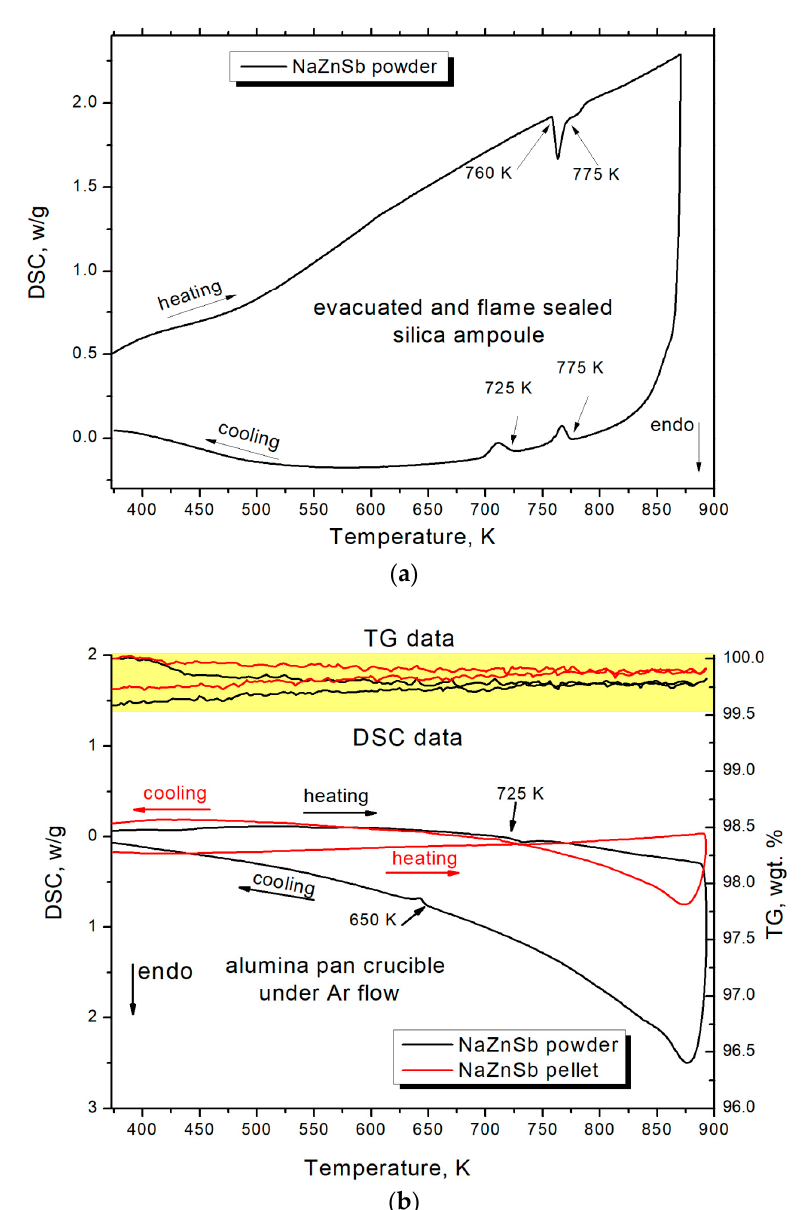
Figure 4. DSC data of the NaZnSb sample obtained for a powdered sample of NaZnSb in an evacuated and flame-sealed silica ampoule ( a ) and combined DSC-TG data for the powdered (black) and SPS sintered (red) samples of NaZnSb measured in an open alumina pan crucible in Ar flow ( b ). Samples were heated from room temperature to 873 K and cooled back to room temperature at a rate of 10 K · min − 1 . Highlighted in yellow is TG data with the TG axis, wt % to the right.